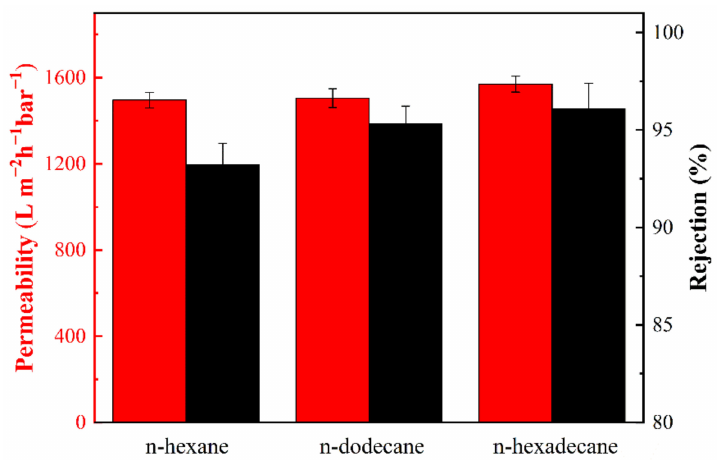
Figure 10. Permeability and separation efficiency of PDA@PAN nanofibrous membrane for oil-in- water emulsions of n-hexane/water, n-dodecane/water and n-cetane/water.